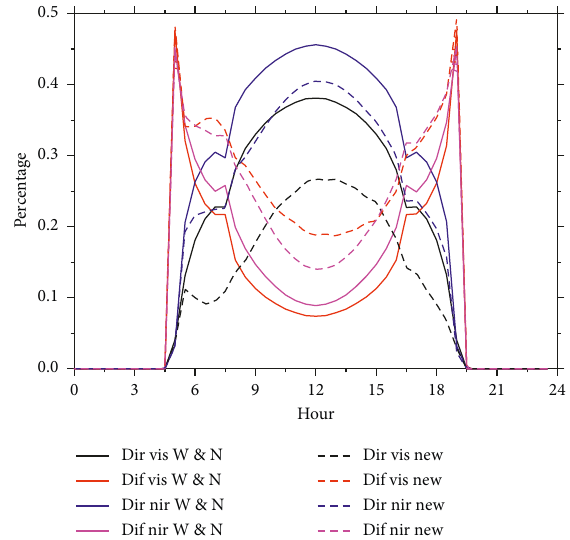
Figure 3: Comparison of the annual averaged diurnal cycle of the solar radiation partitioning between Weiss and Norman and the new surface albedo parameterization